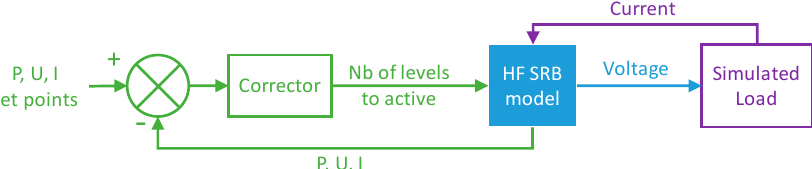
Figure 6. HF SRB model implementation in the simulator.